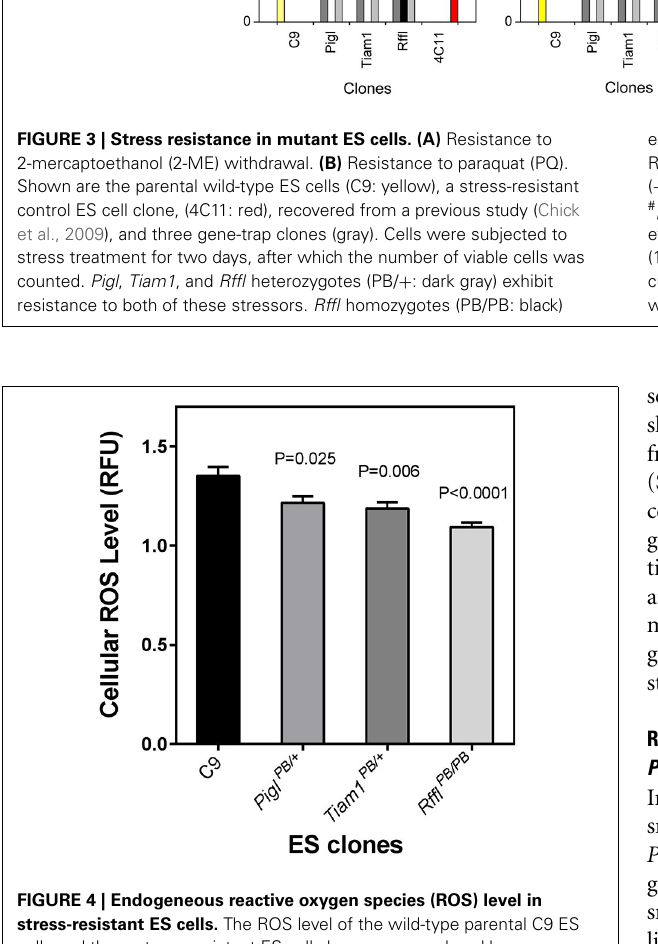
FIGURE 4 | Endogeneous reactive oxygen species (ROS) level in stress-resistant ES cells. The ROS level of the wild-type parental C9 ES cells and three stress-resistant ES cell clones were analyzed by fluorescence spectrophotometry using the CM-H 2 DCFDA fluorescent dye normalized against Hoeshst 33342 which stained for total DNA of the cells in a given well. The fluorescence unit emitted from the CM-DCFDA was divided by the signal emitted from the DNA-bound Hoechst and expressed as a relative fluorescence unit (RFU). Error bars represent s.e.m. of means ( n = 18). The P values evaluated by two tailed Student’s t -test between the wild-type cells and each of the stress-resistant lines are indicated.